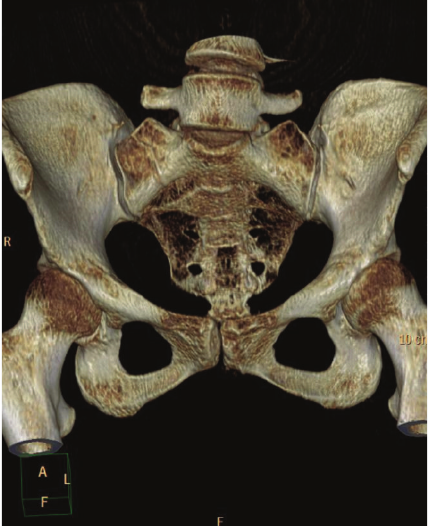
Figure 4: CT scan 3D reconstruction of the pelvis that showed the oblique pattern of fracture line of right sacral